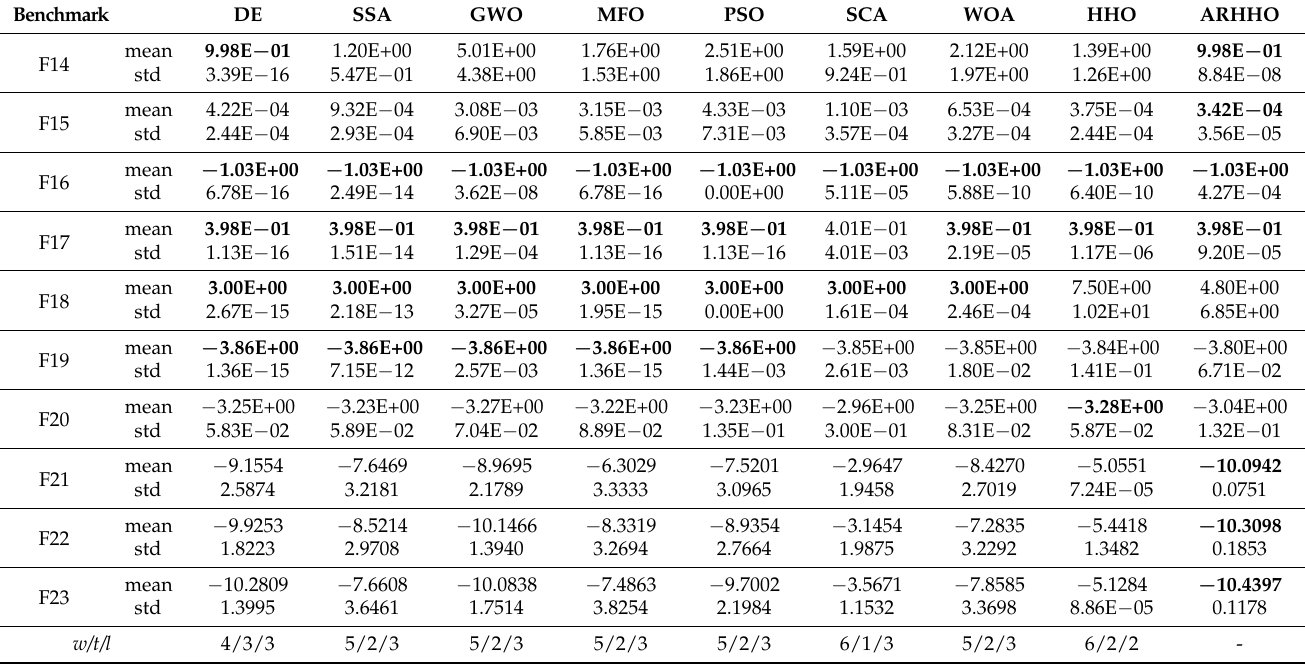
Table 6. Experimental results of benchmark functions F14~F23 in